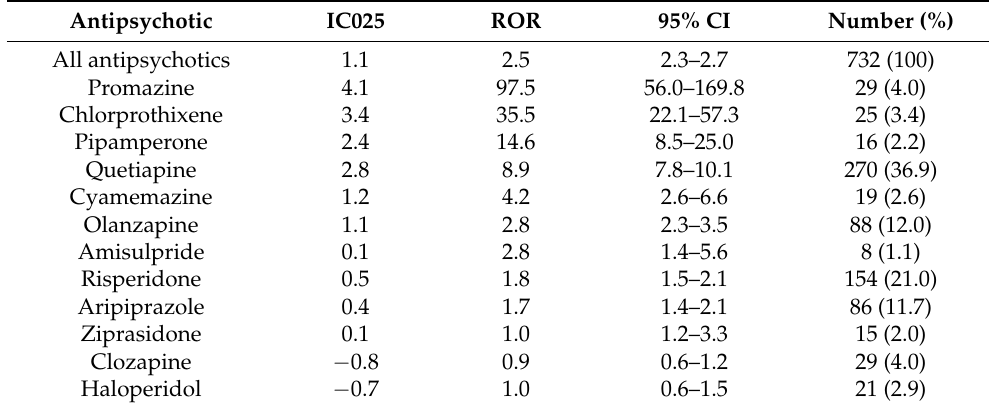
Table 7. Disproportionality analysis for reports of abuse, dependence, or withdrawal in patients aged between 12 years and 17 years, ranked by ROR.